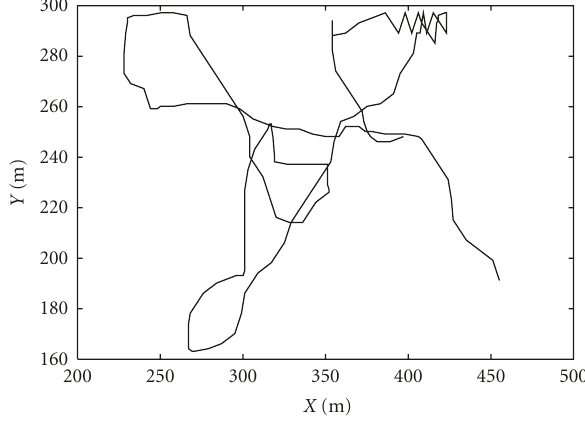
Figure 10: Course of MN using GIMMa